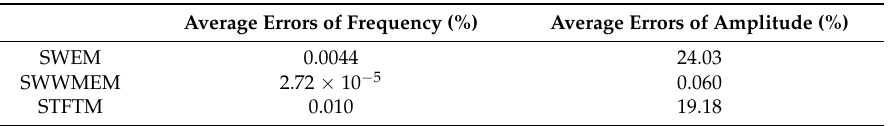
Table 3. Case study 2: Average percentage errors of frequency and amplitude for the frequency-modulated spectral component.